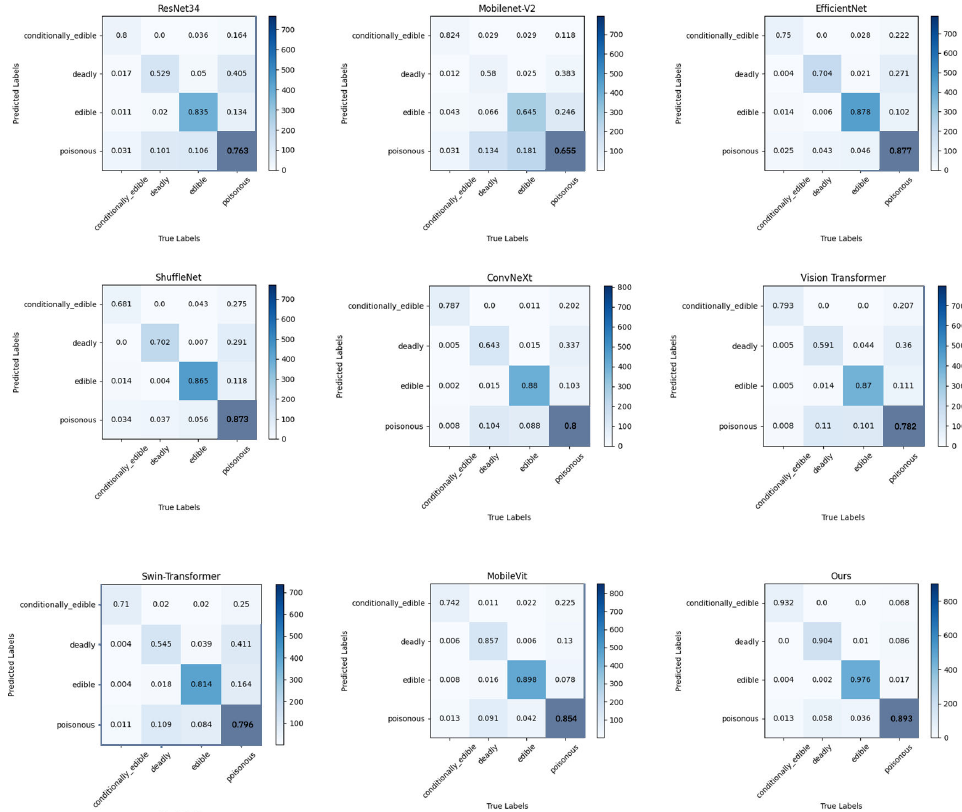
Figure 9. Confusion matrices of the classification results for the mushroom dataset of all